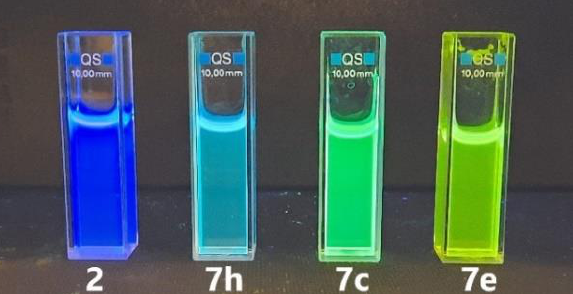
Figure 5. Fluorescence photograph of pyranoindoles 2 , 7h , 7c , and 7e in MeCN solution (1 mM, excitation with a 365 nm Hg